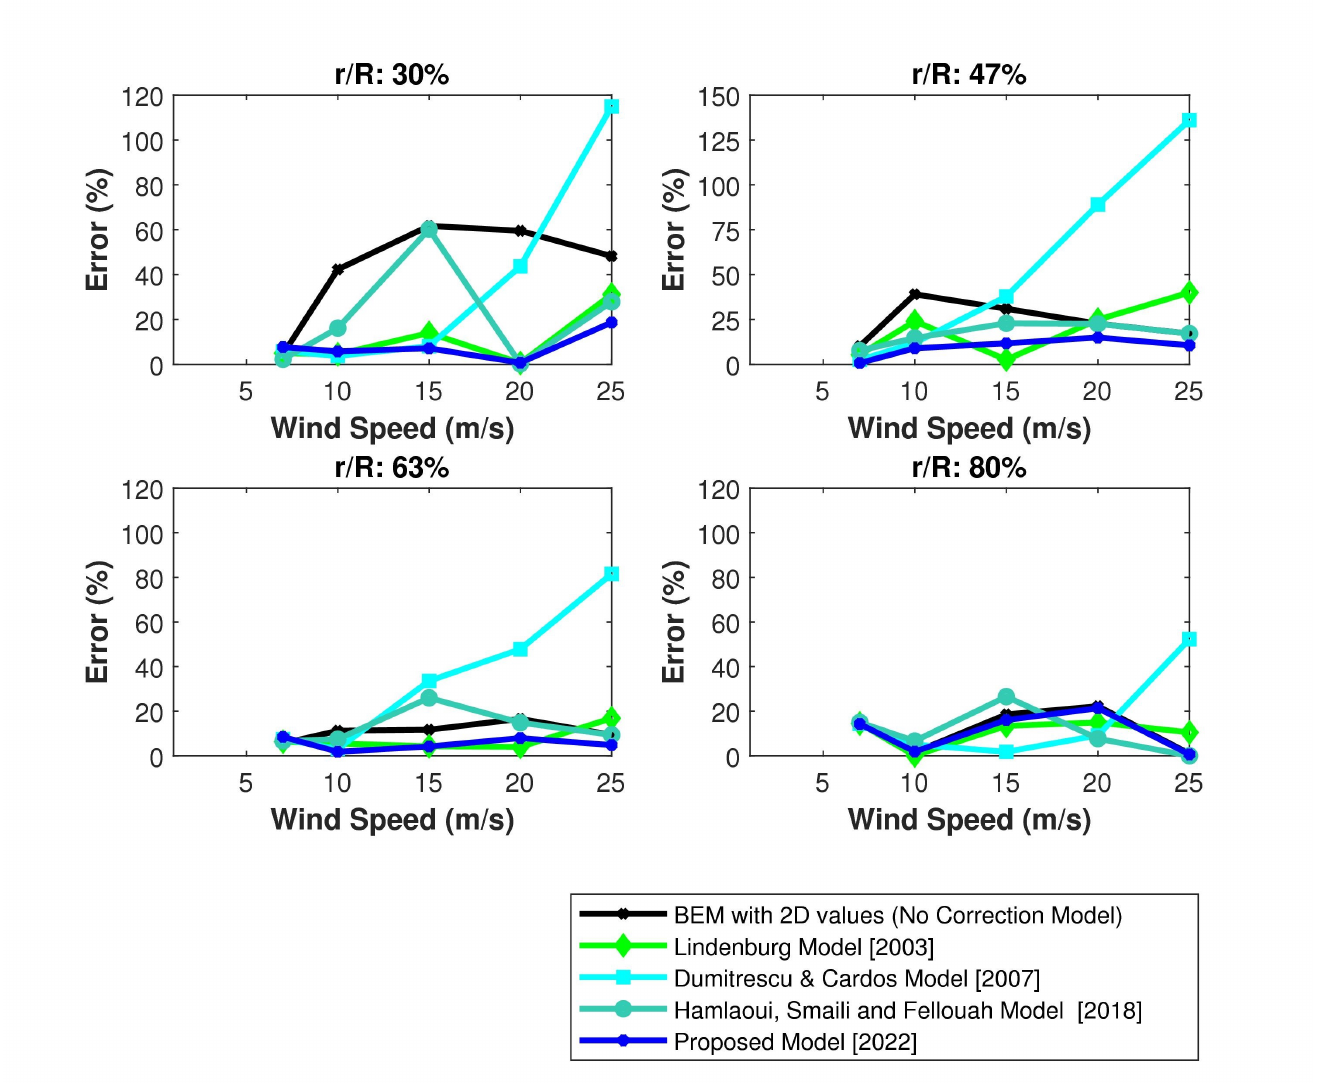
Figure 9. Error in C L computation by each model at different radial positions with different wind speeds for NREL Phase VI